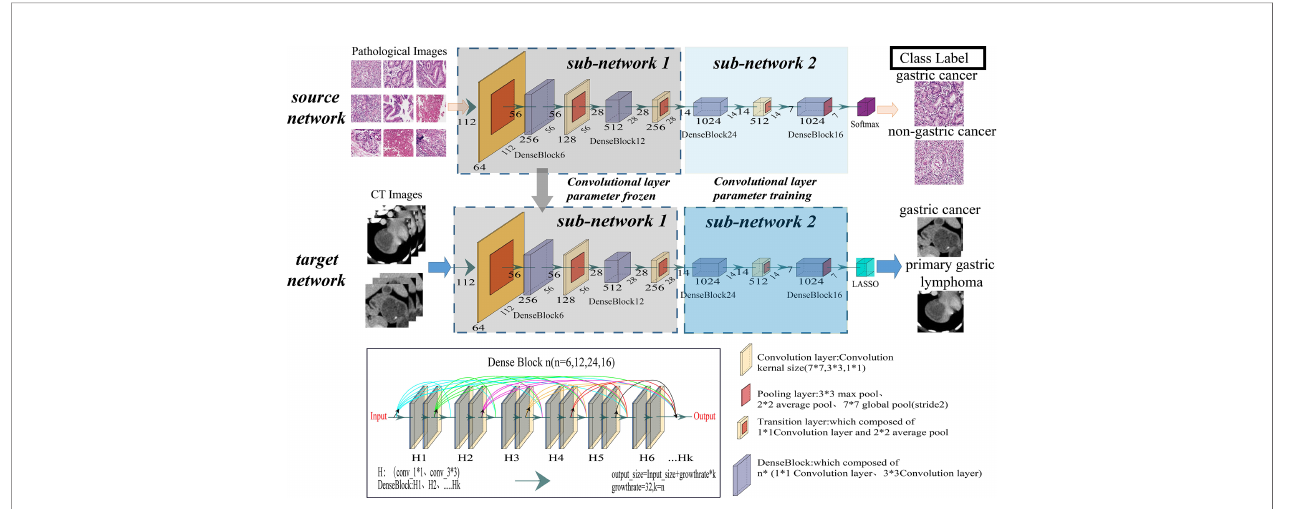
FIGURE 2 | Illustration of the overall transfer learning framework of this study. The convolutional layer of the DenseNet121 model was taken out as the feature extractor of this